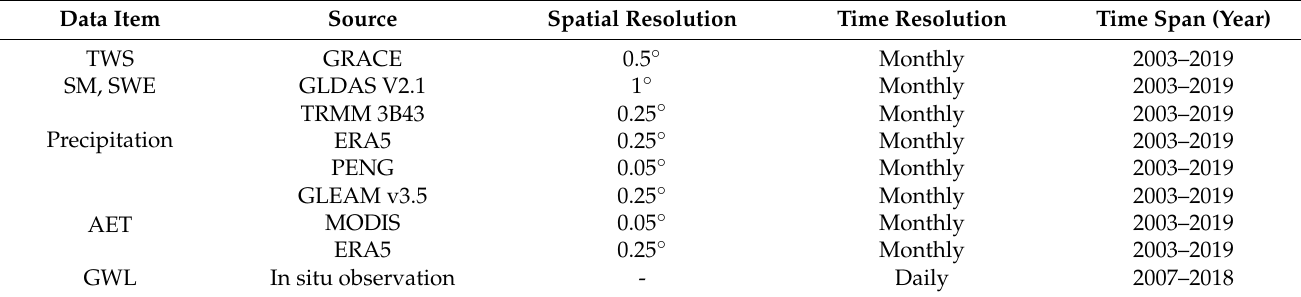
Table 1. Data sources used in this